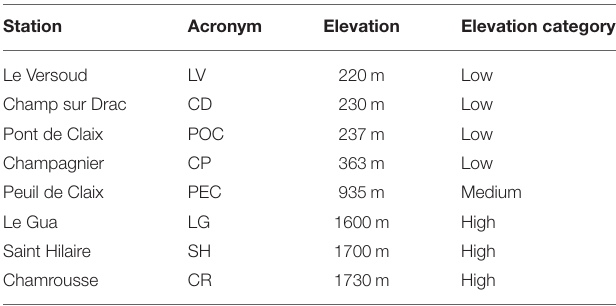
TABLE 1 | Description of the ground-based Automatic Weather Stations in the Grenoble valleys.